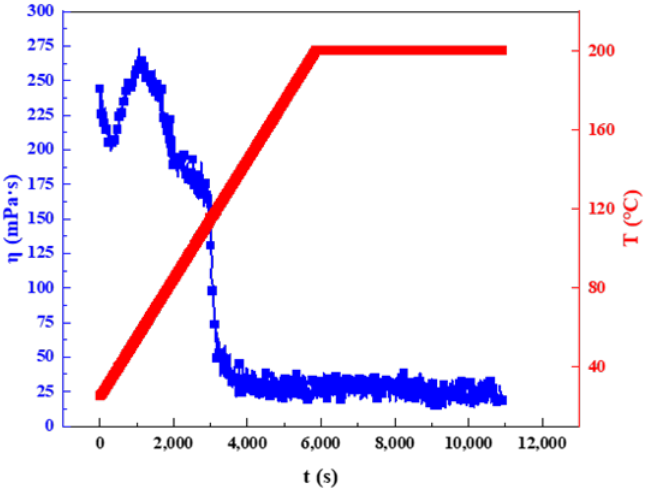
Figure 9. High-temperature thermal stability of GOHAC/NaPts gel solution (the total concentration of GOHAC and NaPts was 40 mmol/L, respectively).